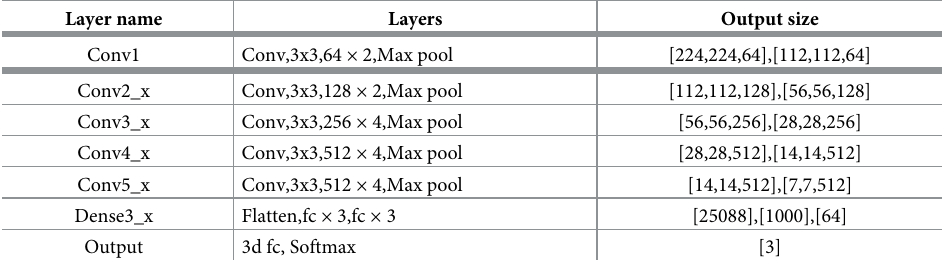
Table 2. Architecture and feature extraction process of VGG-19 for aesthetic-aware